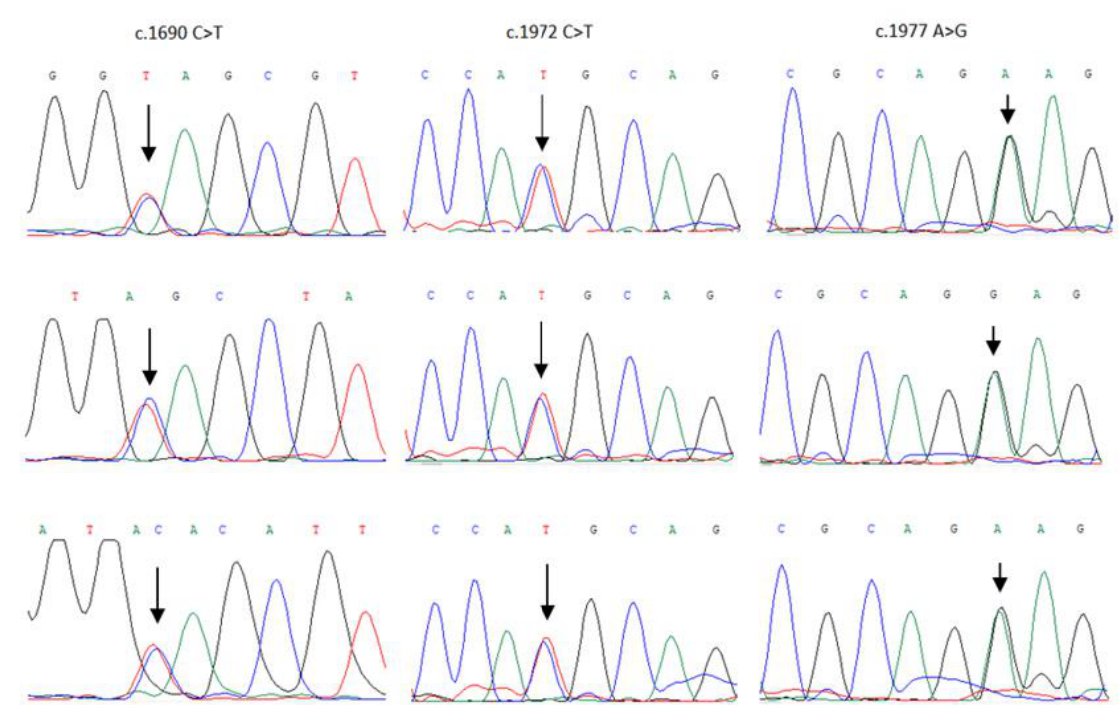
Figure 2. LOH analysis in tumors from nine patients with BARD1 variants (c.1690 C>T, c.1972 C>T and c.1977 A>G). LOH was not observed in any of the nine studied prostate cancers. Localization of BARD1 variants is marked with an arrow ( ↓ ).